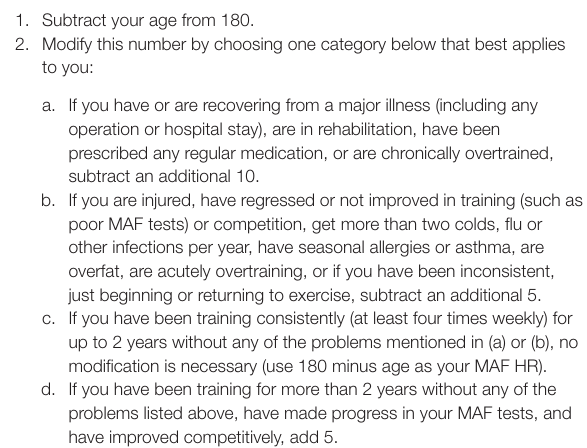
TABLE 1 | Instructions for determining the MAF HR using the 180-Formula.